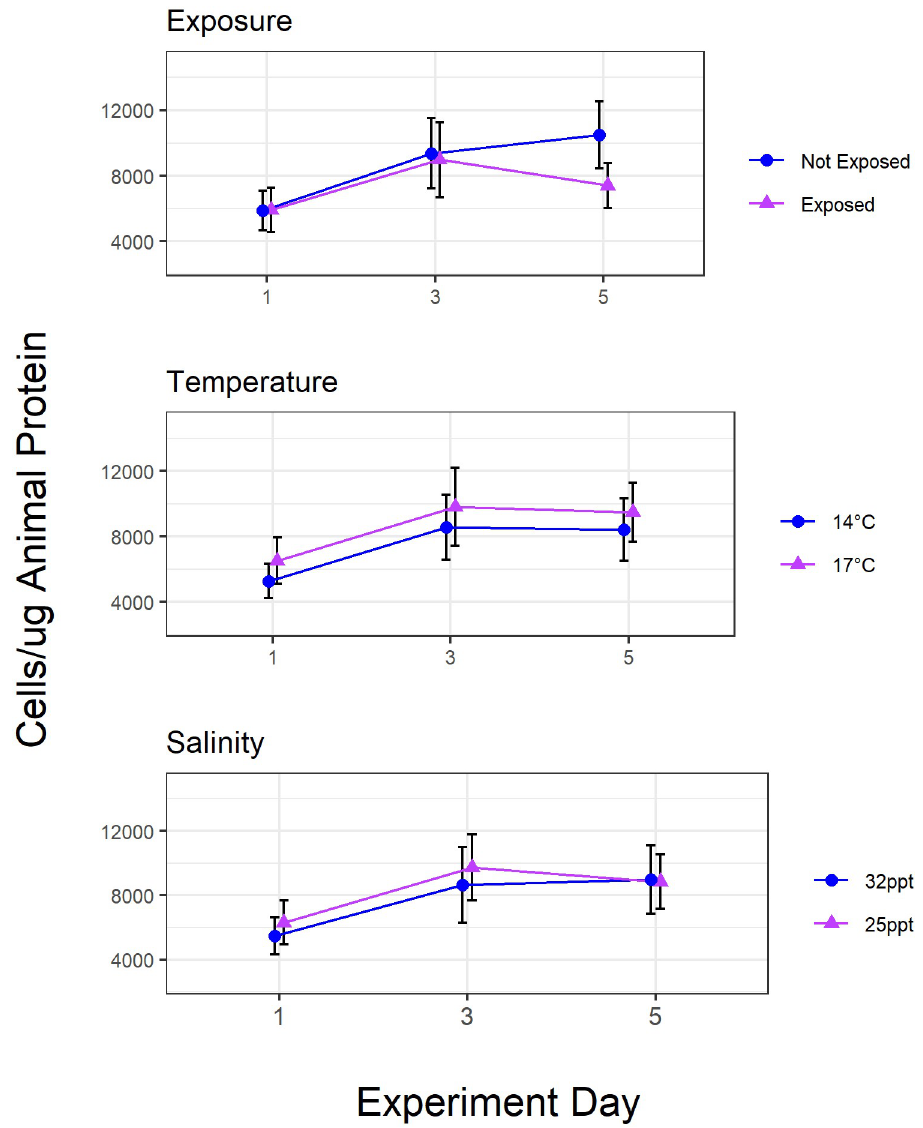
Fig 8. Treatment-specific results from the Pulsed 3-Stressor Experiment. N = 20 per point, error bars show ± CI. The aerial exposure treatment showed significant differences from the not exposed treatment by the end of the experiment. The salinity and temperature treatments did not show significant differences by the end of the experiment. Mean symbiont abundance in the Not Exposed treatment was 5881 ± 2576, 9371 ± 4454, and 10503 ± 4122 cells/ μ g compared to 5913 ± 2872, 8986 ± 4463, and 7397 ± 2879 cells/ μ g in the Exposed Treatment over the three survey days through the five-day experiment.